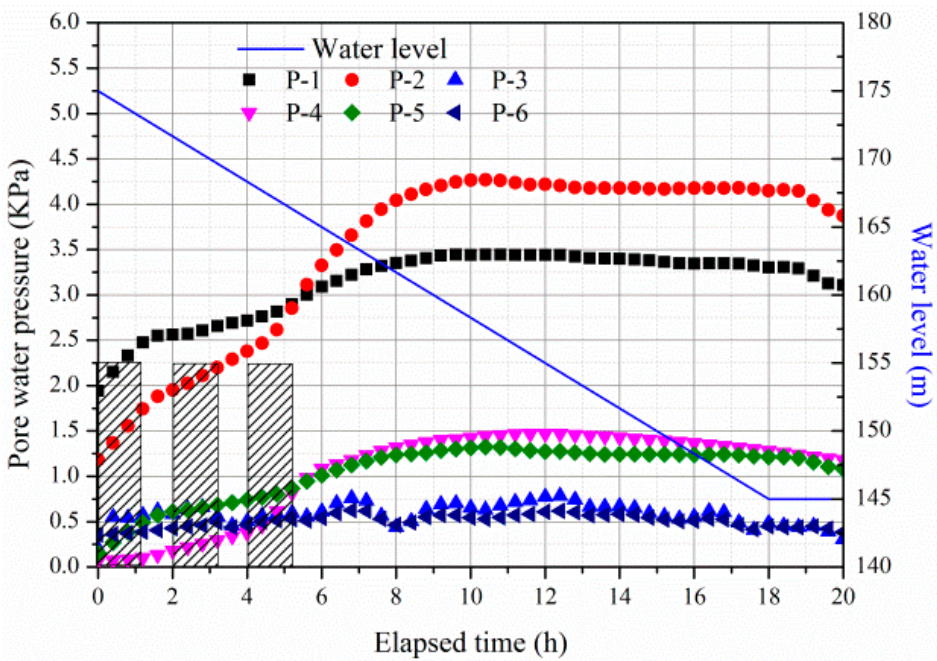
Figure 15. Pore water pressure levels recorded during the water lowering process and rainfall sim- ulations.